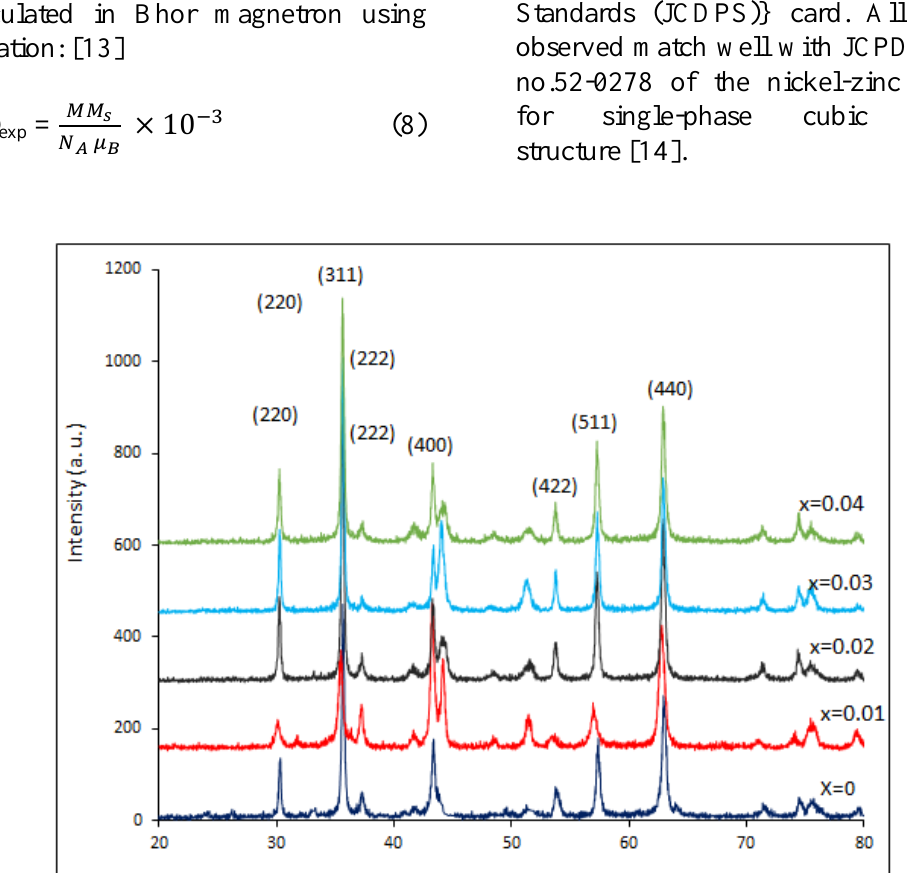
Zn Li Fe O {where x= 0, 0.01, 0.02, 0.03, 0.9-2x 0.1 x 2+x 4